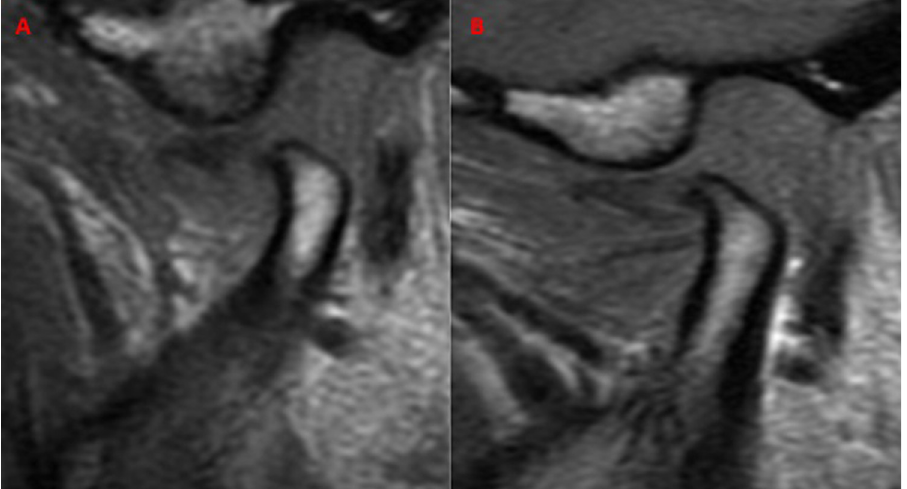
Fig 2. NC example. A: before the arthrocentesis. B: four months after arthrocentesis.